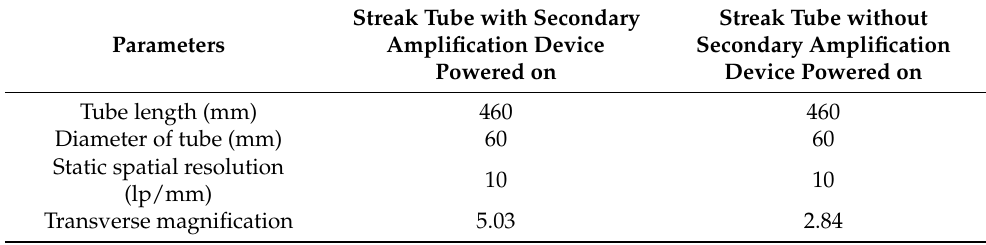
Table 5. Comparison of imaging performance of the streak tube without and with secondary amplifi- cation device powered